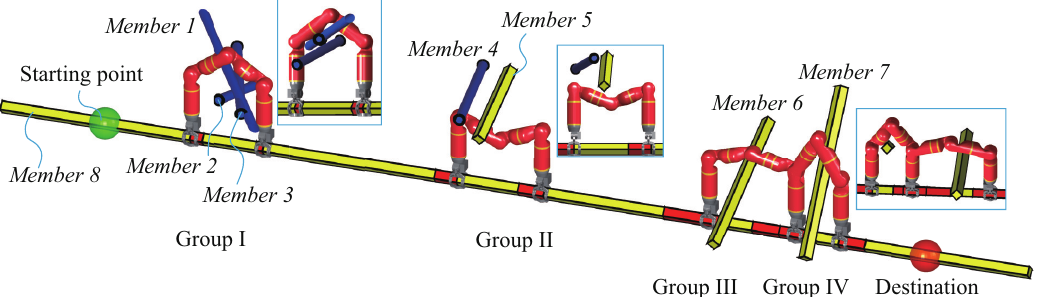
Figure 10. The results of computing operational regions for negotiating an obstacle in various pose.